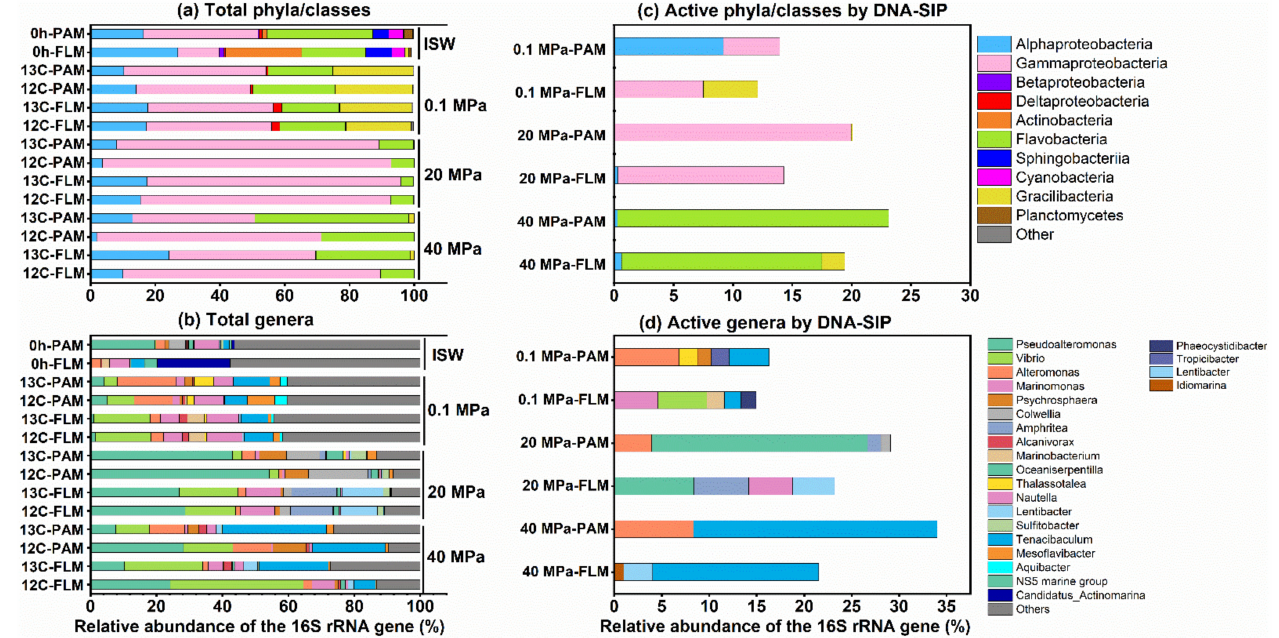
Figure 3. The most abundant total and active PAM and FLM classes and genera (>1% of the relative abundance) for POC utilization at 0.1, 20, and 40 MPa, respectively. ( a , b ) The total PAM and FLM communities at phylum/class and genus level, respectively. ( c , d ) Active PAM and FLM taxa identified by DNA-SIP at phylum/class and genus level,